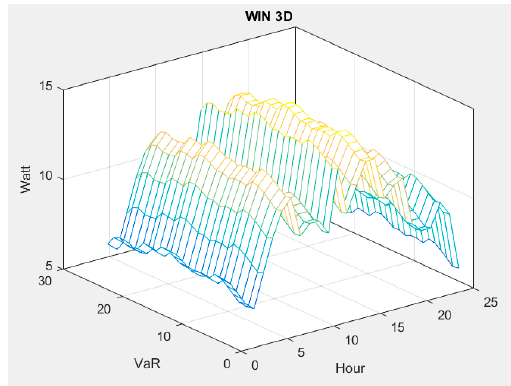
Figure 9. Power generation of WTs for the different risk levels.